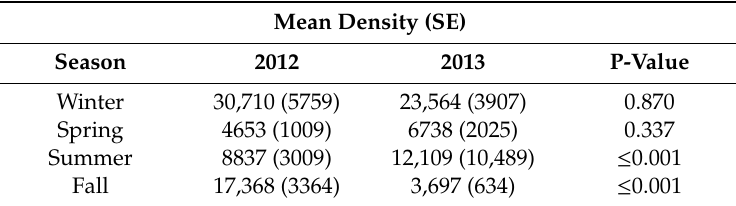
Mean Density (SE)